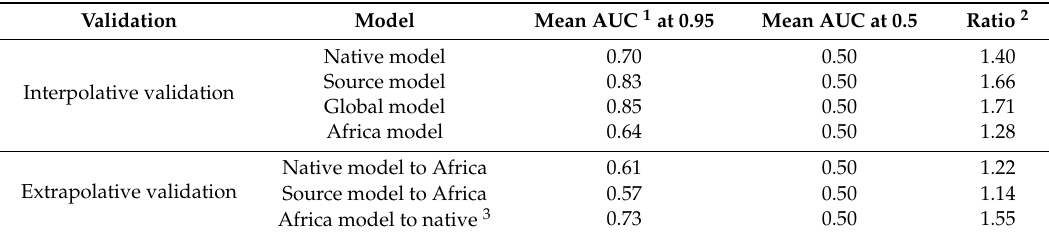
Table 1. Interpolative and extrapolative validations of niche model